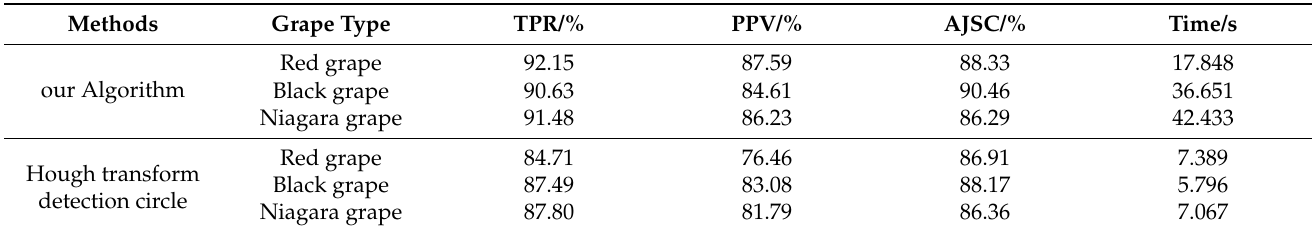
Table 2. Comparison of detection results of different methods on various grape berries.